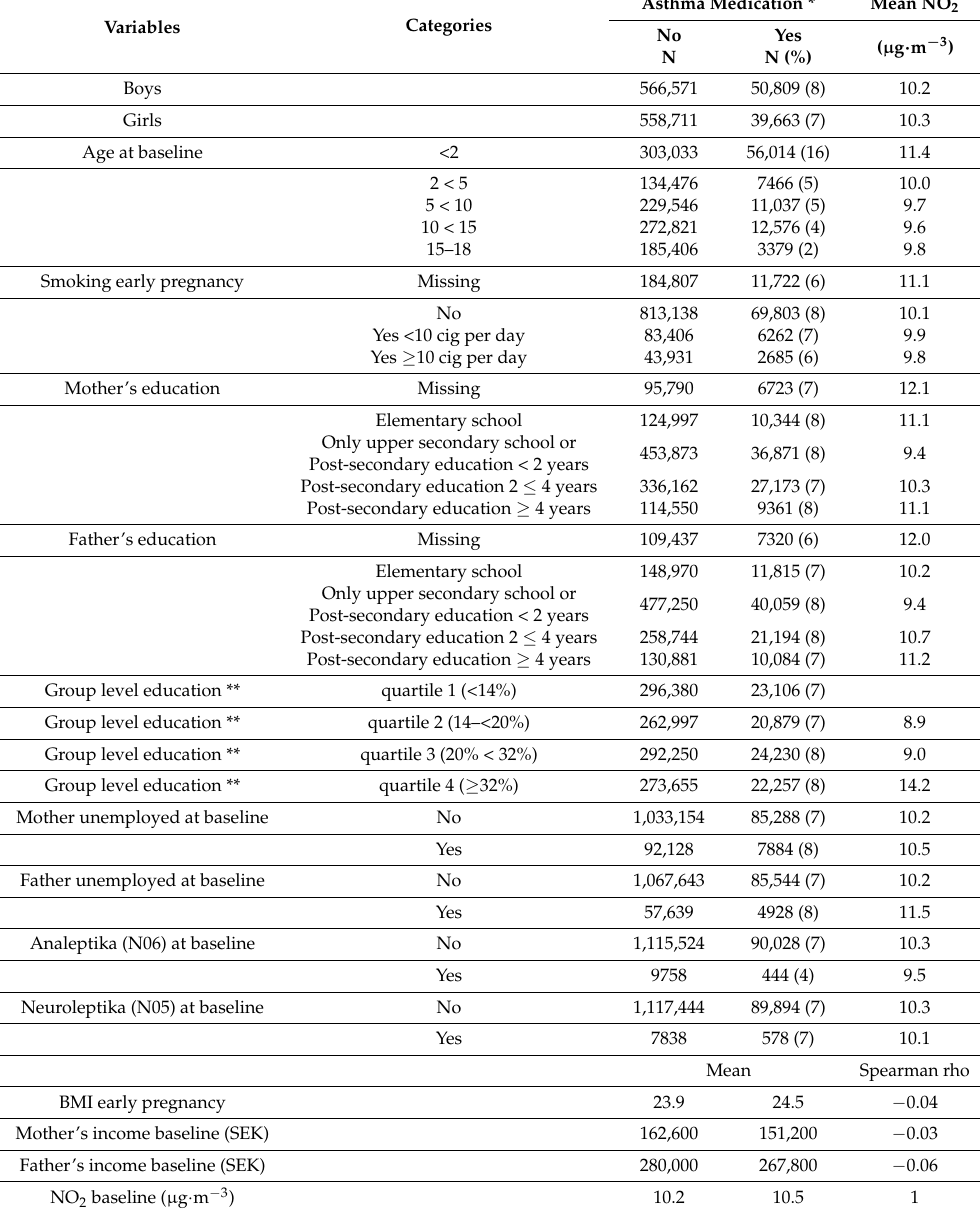
Table 1. Descriptive data for variables used in the study, stratified by asthma medication and mean levels of NO 2 ( µ g · m − 3